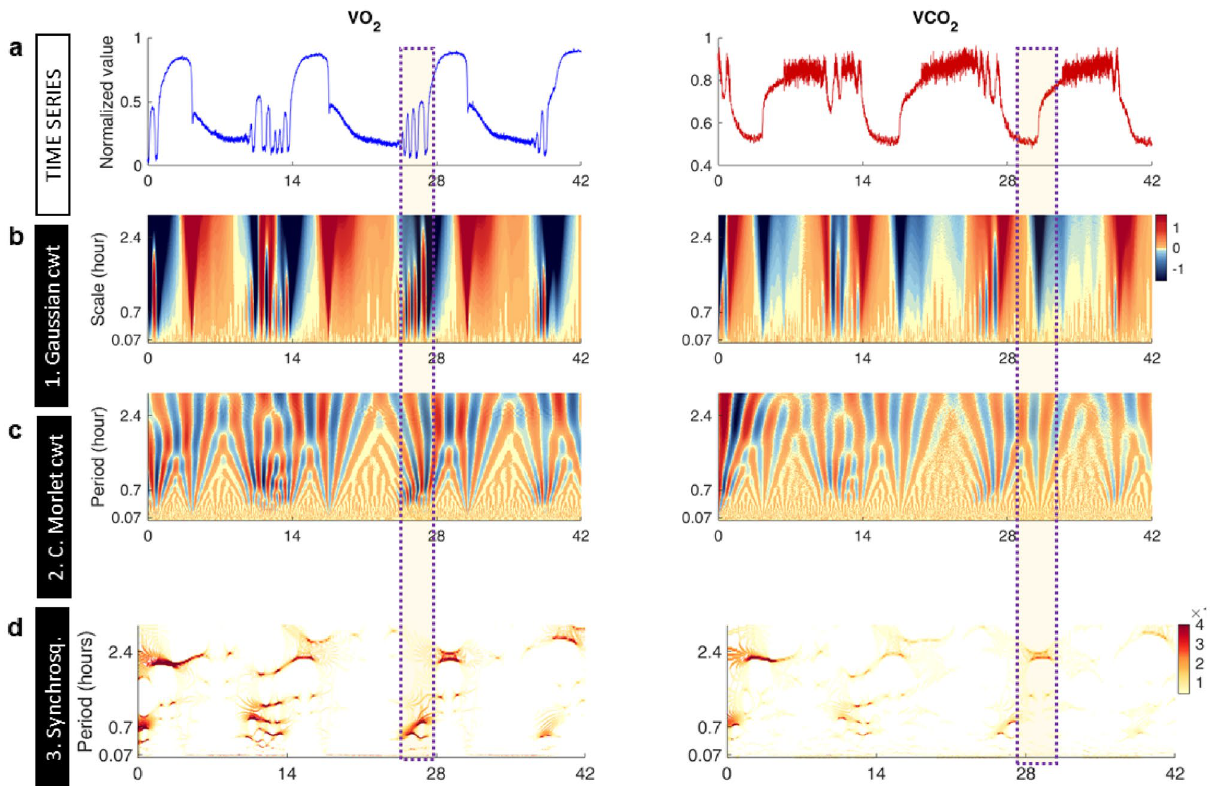
Figure 2. Detection and localization of higher frequency oscillations in O 2 and CO 2 signals obtained by MIMS from oscillating continuous cultures of S. cerevisiae . ( a ) Zoom in on the same time series shown in Fig. 1a of the relative MIMS signals of the m/z = 32 and 44 components vs time, corresponding to the O 2 (blue) and CO 2 (red) signals, respectively. Time is given in hours after start of the fermentor’s continuous operation. ( b ) Magnification of the same Gaussian cwt analysis shown in Fig. 1b. This wavelet highlights variability and transitions between states at a given time scale. Note the appearance of vertical lines around the 1 h time scale. ( c ) Magnification of the complex Morlet cwt analysis displayed in Fig. 1c (only the real part is shown). The bifurcation-like pattern marks the different periodic oscillations that compose the signal. ( d ) Magnification of the same wavelet synchrosqueezing analysis presented in Fig. 1d. Dark vertical localized bands indicate the estimated period of the signal at the time scales that appear in specific temporal windows. Note the thin red line at 4 min (0.07 h) period in the O 2 synchrosqueezing coefficients (see zoom in Fig. S1). Color scale was adjusted to improve apparently coexisting with ultradian rhythms which have frequencies that are multiples of the principal oscil- lator, as exemplified by the phase angle representations shown for VO 2 in yeast, mice, quails in Fig. 5a, and for rats in Fig. S6c. The complex dynamics observed in yeast can be easily understood as a sum of sinusoidal oscil- lations (see Fig. S11, and 42 ). However, for the time series from vertebrates, two possible hypothetical scenarios can underlie the dynamic pattern observed: (i) a sum of sinusoidal coexisting oscillations from circadian and ultradian origin (Fig. 5b, left column), or (ii) a sum of non-sinusoidal oscillations of circadian origin 24 h out of phase (Fig. 5b, right column). According to the former scenario, the subsequent ultradian rhythms (i.e., 12 h, 8 h) present characteristic phase and power relationships with regard to the circadian rhythm, whereas the second scenario postulates that only circadian rhythms happen to occur 24 h out of phase with each other. A similar branching pattern in the complex Morlet cwt arises in both scenarios (Fig. 5c), however, comparatively, the second is less parsimonious because it demands not only precise timing of the phase between peaks but also of their amplitudes. Further insight is provided in Fig. 6 where the analytical scheme of experimental data displayed in Figs. 1, 3, 4 and S6 are shown (time series shown as a filled area) superimposed with the extracted sinusoidal oscillations (bold colored lines). Importantly, the resultant pattern of 24 h, 12 h and 8 h is reproduced by wavelet analysis of the synthetic time series produced according to the first scenario (Fig. 5, compare panels a-left with panel c, left column). Moreover, the synthetic time series depicted in Fig. 5b (left column, bold trace) simulates the experi- mental time series of the rate of O 2 consumption (VO 2 ) in mice and rats (see Fig. 6, second and third columns, respectively, and Fig. S12 for mice where, in addition to VO 2 , CO 2 release rate (VCO 2 ), spontaneous locomotor activity, and food intake are plotted) and of quails’ activity (Fig. 6, fourth column). Yeast data, also included in Fig. 6 (left column), further supports the concept of rhythms coexistence at different temporal scales.